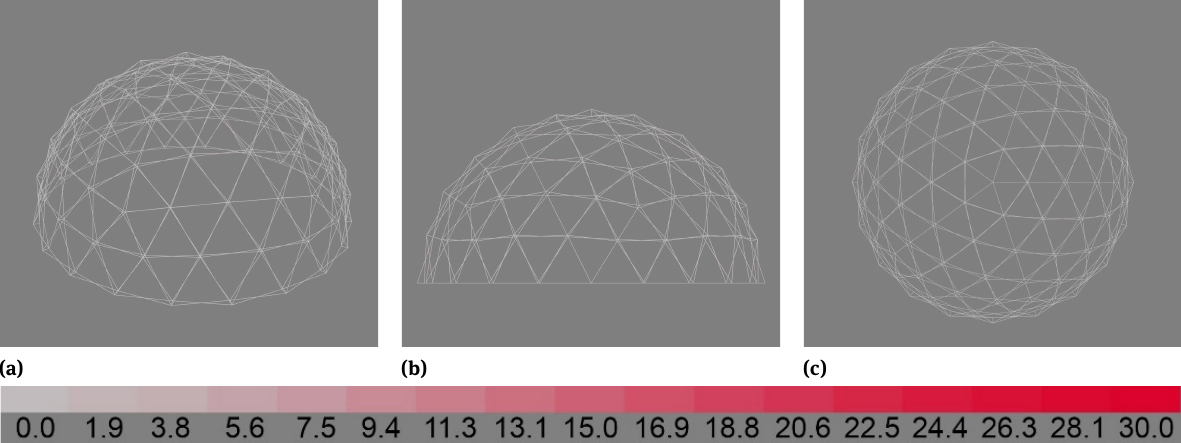
Figure 18: Pole structure under the wind load (0.39 kN/m 2 ). a) 3D view, b) Side view, c) Top view. Maximum displacement: 3.38 cm